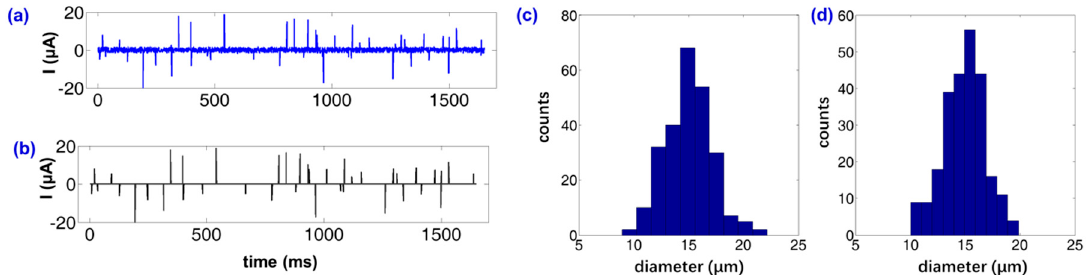
Figure 6. Experimental results of abrasive grains detection. Both ( a ) and ( b ) provide an example of abrasive grain detection. ( a ) The real-time current signal obtained from the impedance analyzer. ( b ) Real-time current signal processed by a customized filter. Here, the signals smaller than the I n (the threshold current to distinguish the particle signals from background noise) were cut off as zero. Both ( c ) and ( d ) present the distribution of abrasive grains in the oil, obtained by the commercial equipment and the device fabricated in this work.